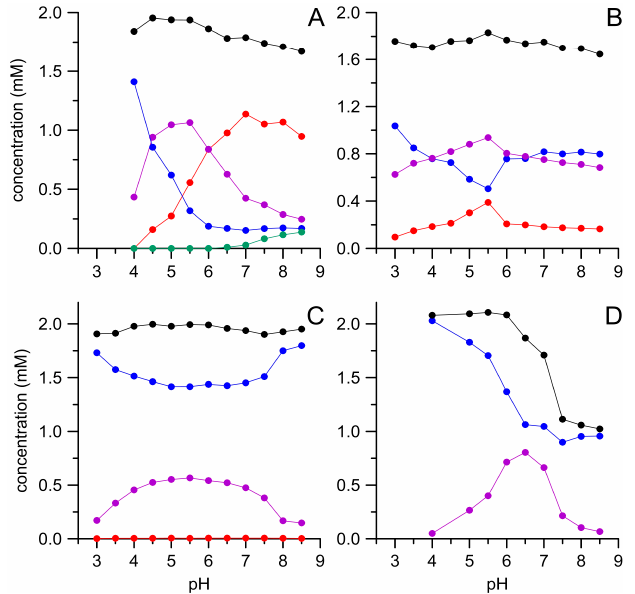
Figure 1. Enzymatic oxidation of 5-hydroxymethylfurfural (HMF) by different oxidases in dependence of the pH. Pery AAO ( A ), Post AAO ( B ), Badu AAO ( C ), and galactose oxidase (GAO) ( D ); HMF (blue), 5-diformylfuran (DFF) (violet), HMFCA (green), 5-formyl-2-furancarboxylic acid (FFCA) (red), and sum of HMF and its derivatives (black). Data points are means of triplicate measurements with standard deviations <5%.